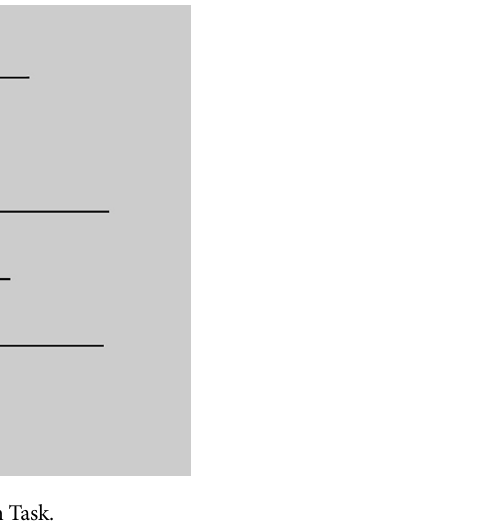
Figure 1. The design of the Line Bisection